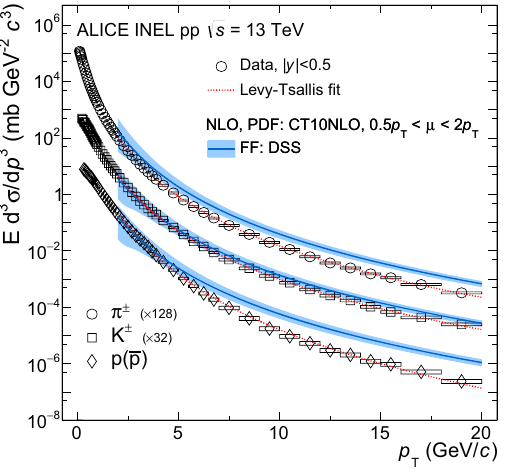
Fig. 17 (Left) Invariant differential cross sections for π ± , K ± , and p ( p ) production, compared with NLO pQCD calculations using CT10NLOPDFs[101]withDSS14FFs[5]for π ± andDSSFFs[3,102] for K ± and p ( p ) . The shaded bands around the NLO calculations corre- spond to the scale uncertainty. (Right) Ratio of measured data (points)